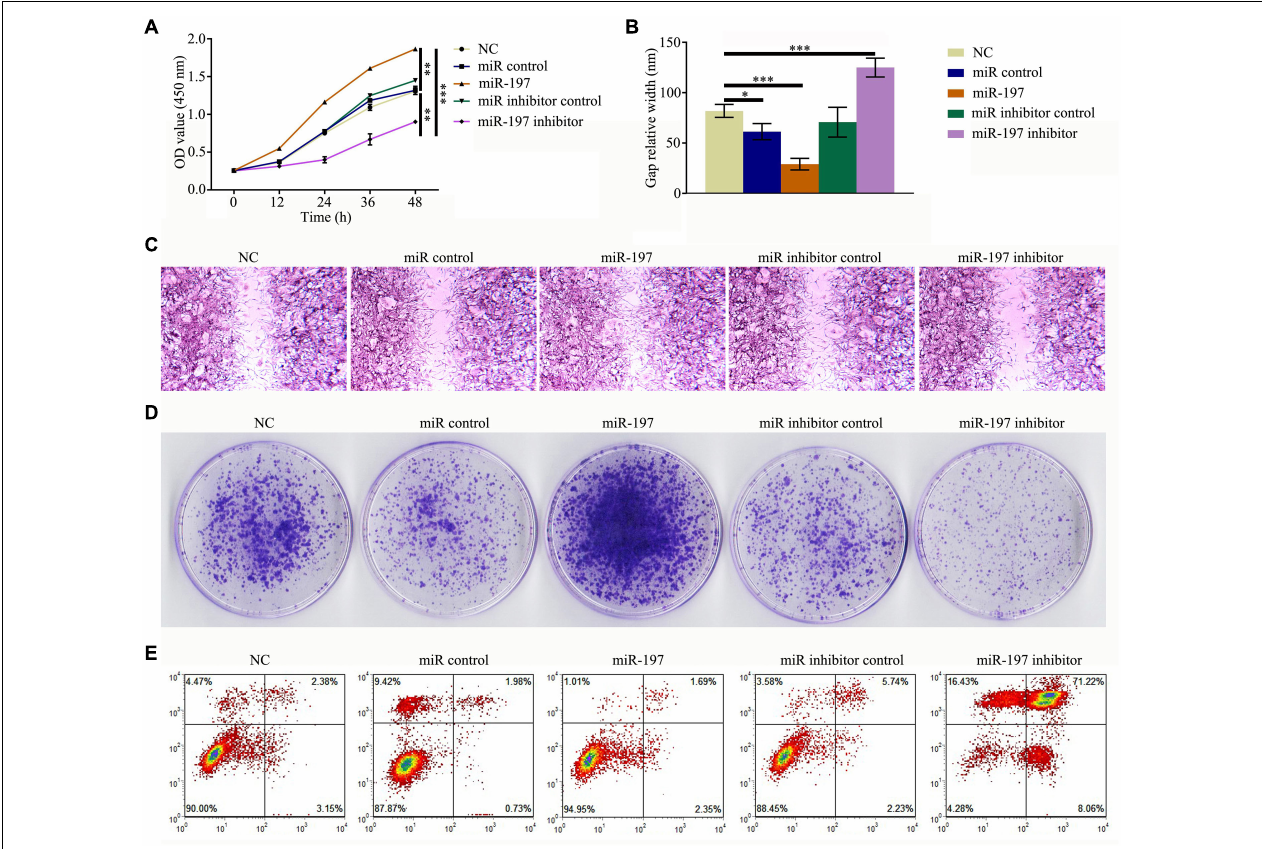
FIGURE 3 | MiR-197 inhibitor is a potential suppressor of prostate cancer. PC3 was transfected with miR-197 mimics or miR-197 inhibitor. (A) Cell Counting Kit-8 (CCK-8) assay was conducted to detect the level of cell proliferation. (B,C) Cell scratch assay was conducted to determine the effect of miRNAs on prostate cancer stem cell (PCSC) migration. (D) Colony formation assay was conducted to observe PCSC growth features. (E) An Annexin V-FITC/PI apoptosis detection kit and flow cytometry were used to evaluate PCSC apoptosis. * p < 0.05, ** p < 0.01, *** p <